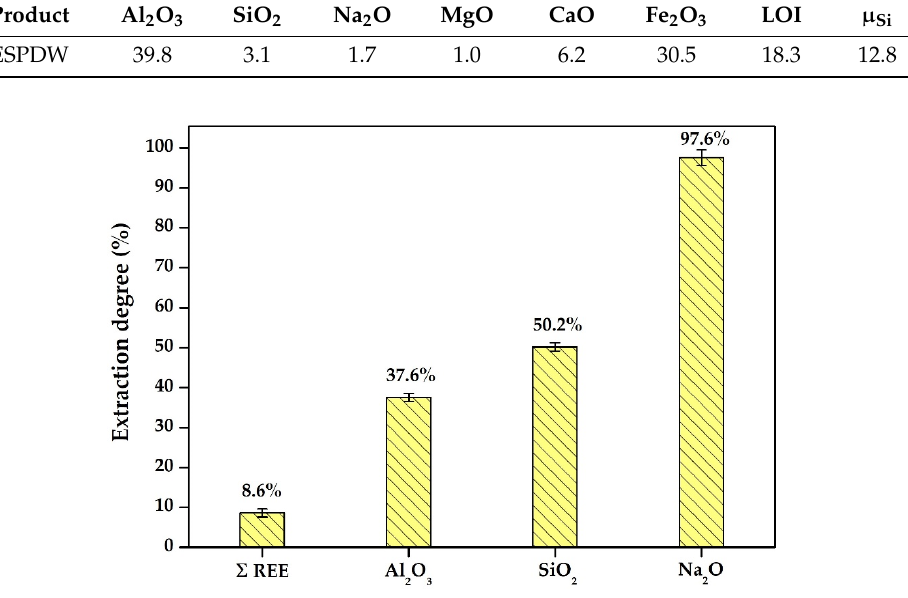
Figure 4. The extraction degree of the main components into the liquor by water leaching of electrostatic precipitator dust.